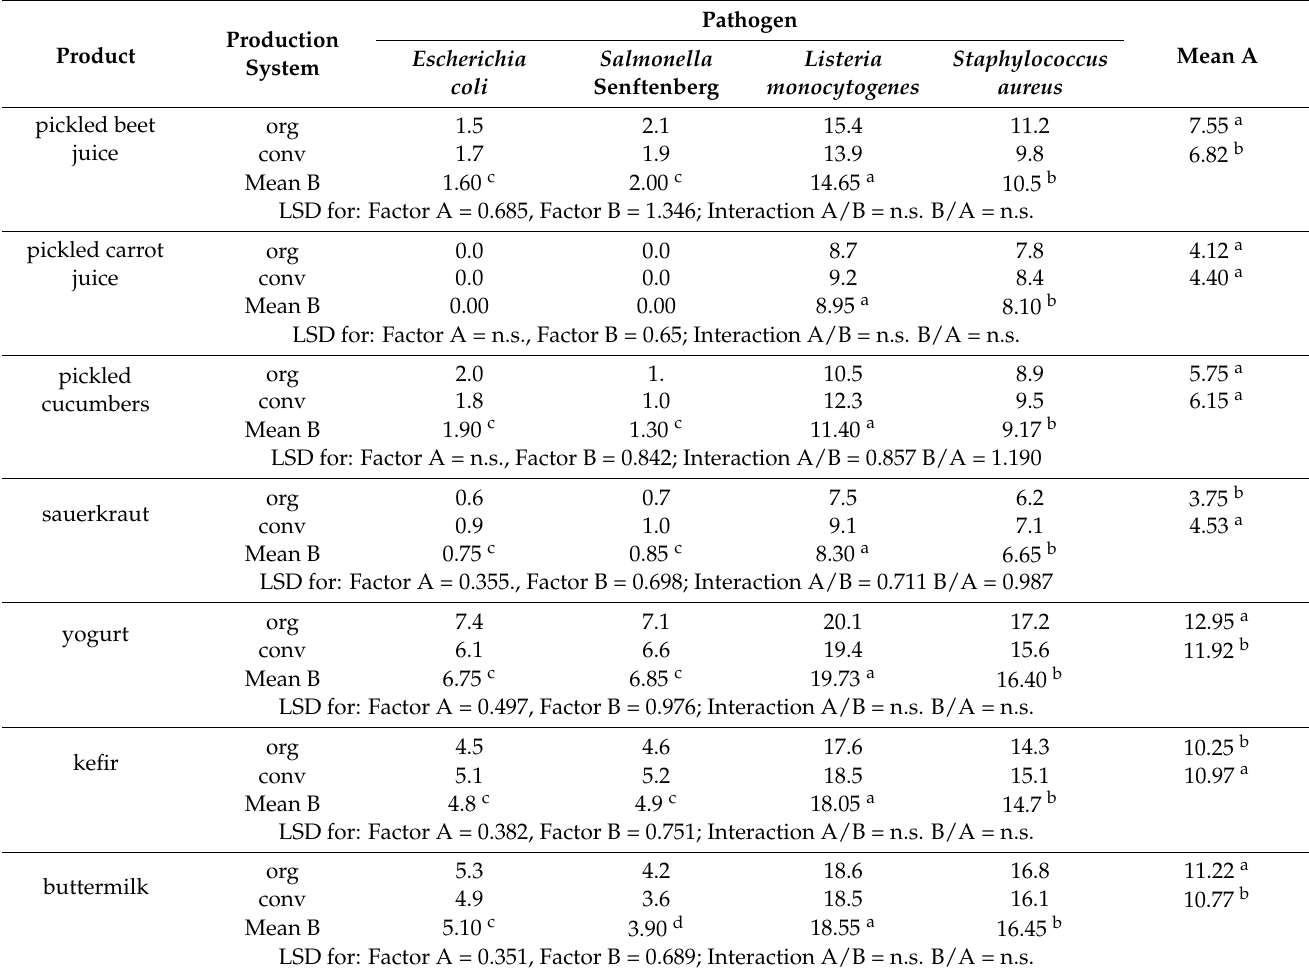
Table 2. Size of the inhibition zones of pathogen growth [mm] induced by bacteriocins of lactic acid bacteria isolated from fermented